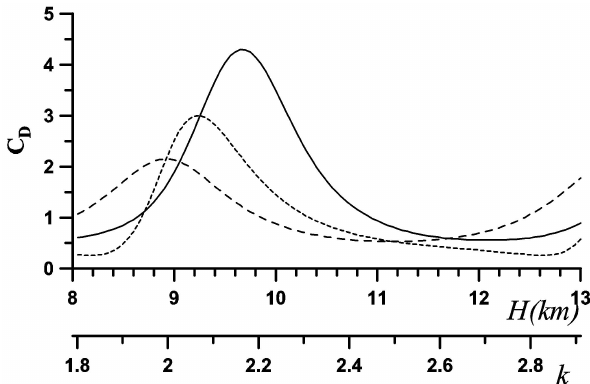
Fig. 1. The first order (long dashed) and second order (dashed) approximations to the wave drag for the Witch of Agnesi profile, as given by Eq. (45) and Eq. (43), relative to the hydrostatic value (solid), as given by Eq.